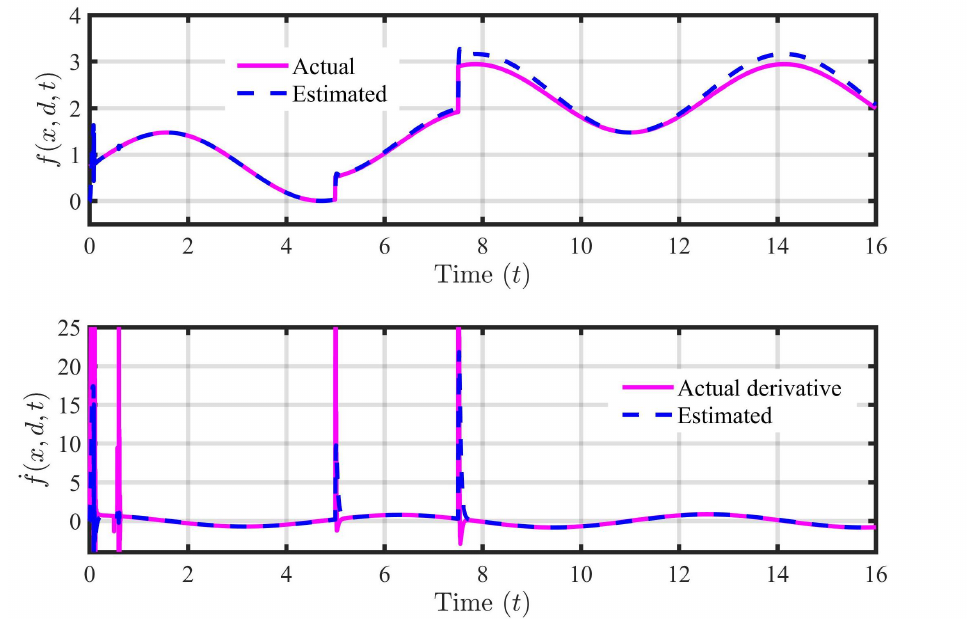
Figure 12. DESO − based estimation of mismatched lumped disturbance and its first-order